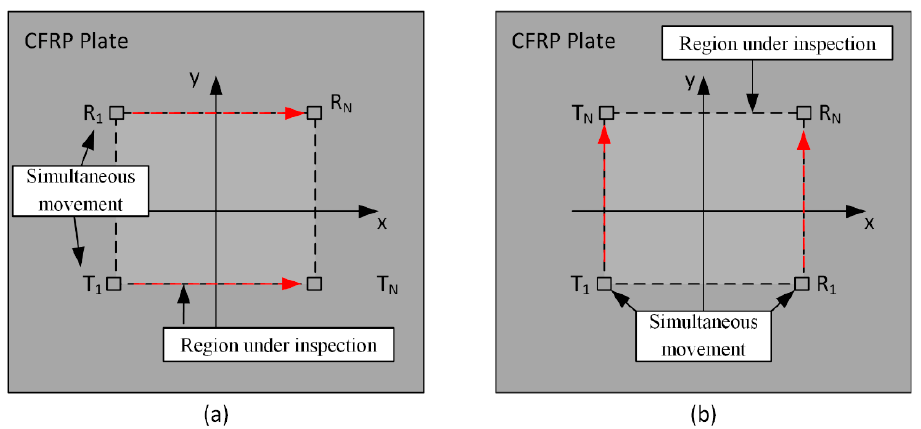
Figure 8. Representation of the two scans used to collect data for the guided-wave-tomography reconstruction: ( a ) B − scan performed along the fiber oriented at 0 degrees and ( b ) B − scan performed along the fiber oriented at 90 degrees.